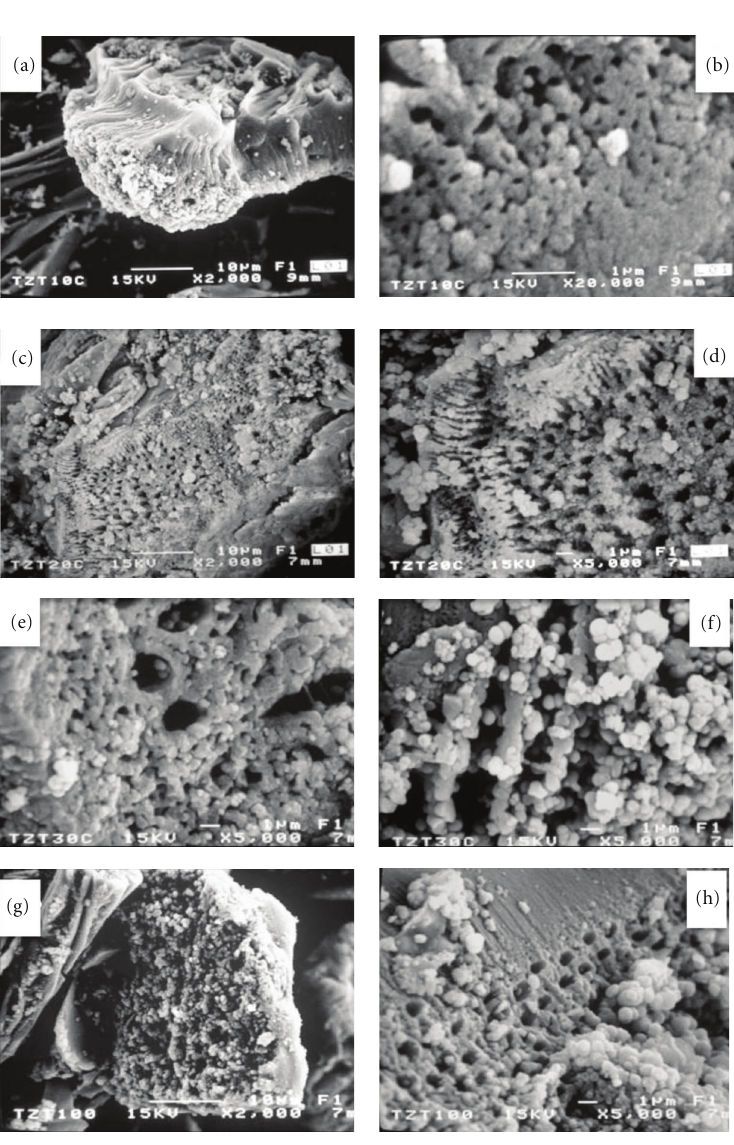
Figure 5: SEM micrographs of the T10Z-400 sample ((a) and (b)), T20Z-400 sample ((c) and (d)), T30Z-400 sample ((e) and (f)), and Z-400 sample ((g) and (h)).